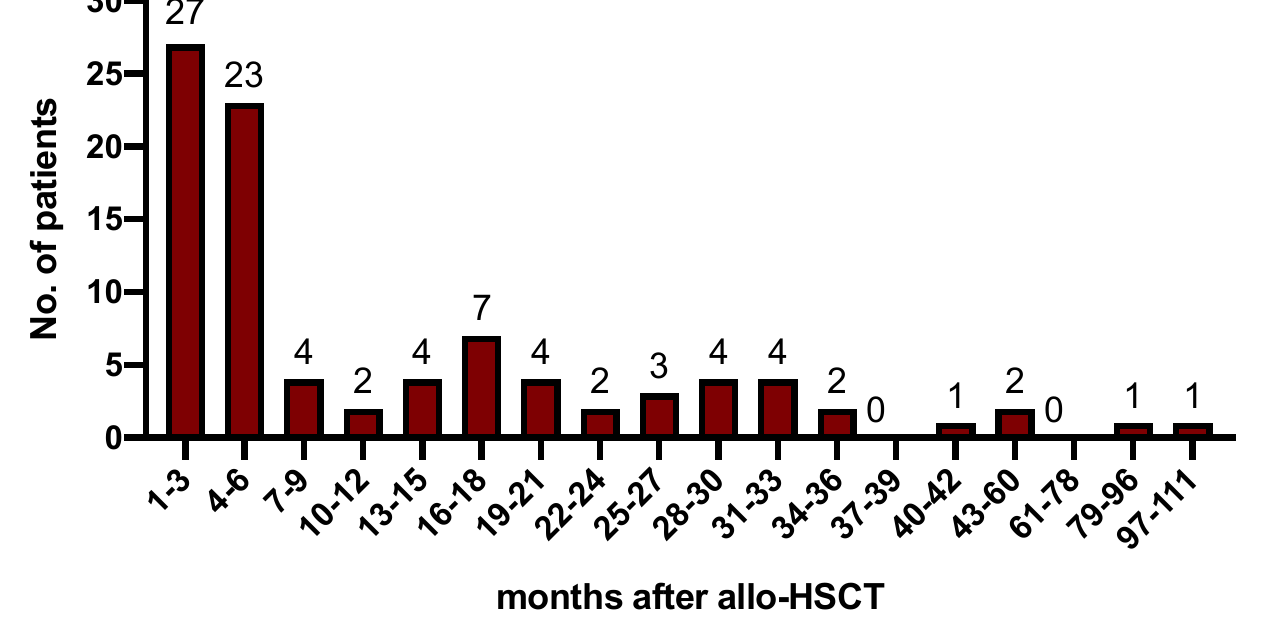
Figure 1. Timepoint of post-transplant relapses. Median time from allo-SCT to relapse was 5.5 months (range 0.5 to 109.8 months), and 30%, 55%, 62%, 80% and 100% relapsed within 3, 6, 12, 24 and >24 months, respectively. No., number.